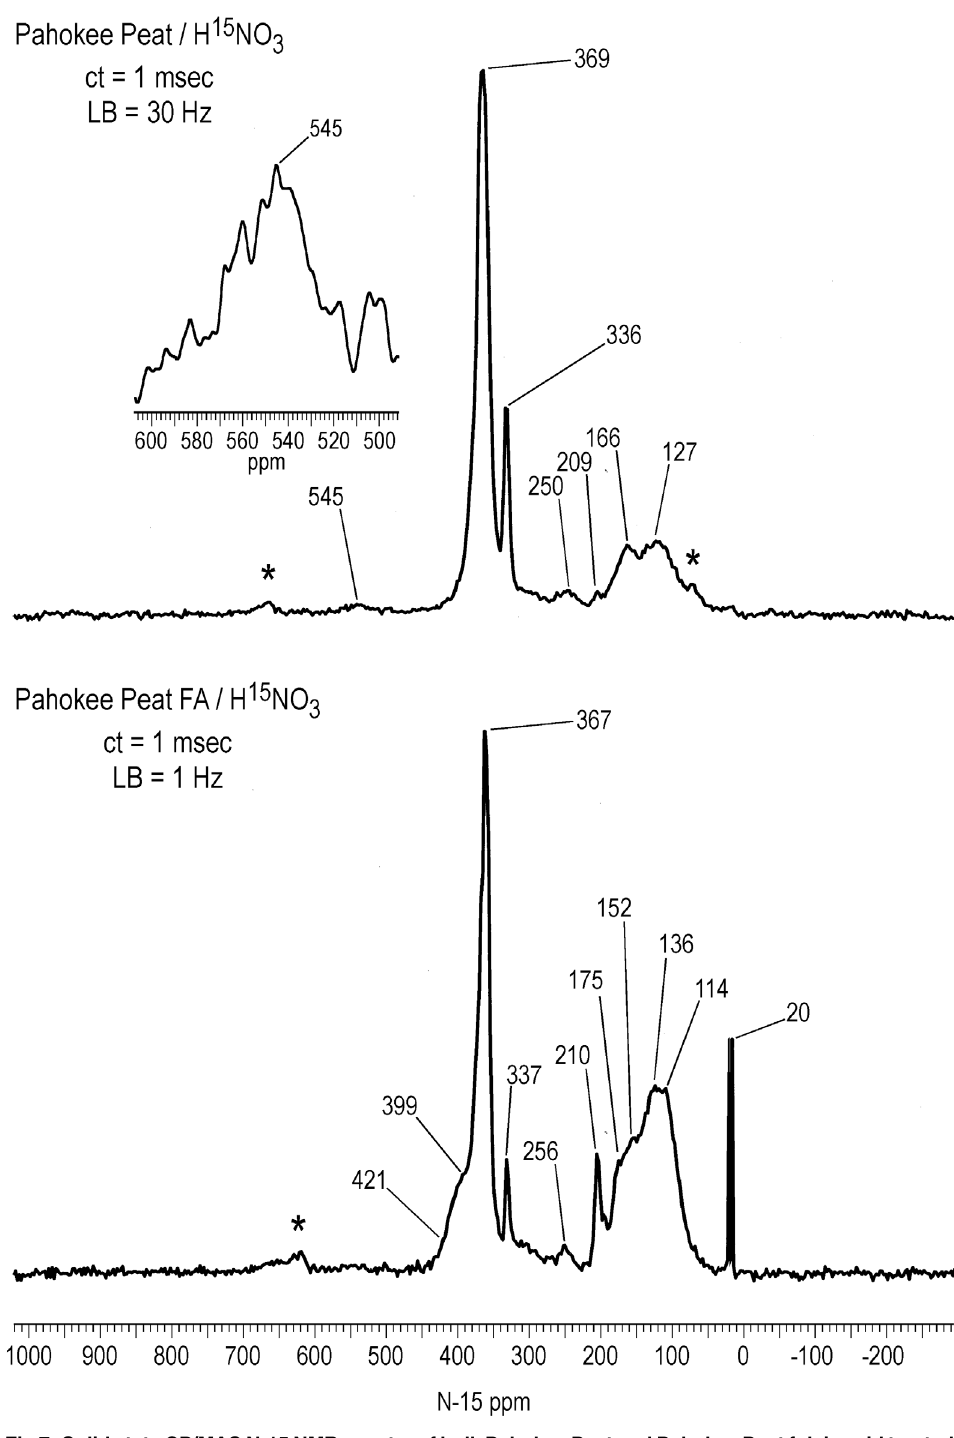
Fig 7. Solid state CP/MAS N-15 NMR spectra of bulk Pahokee Peat and Pahokee Peat fulvic acid treated with N-15 labeled nitric acid. ct = contact time. LB = line broadening. Spinning speeds for peat and peat fulvic acid were 6 kHz and 5 kHz, respectively. Asterisks denote spinning